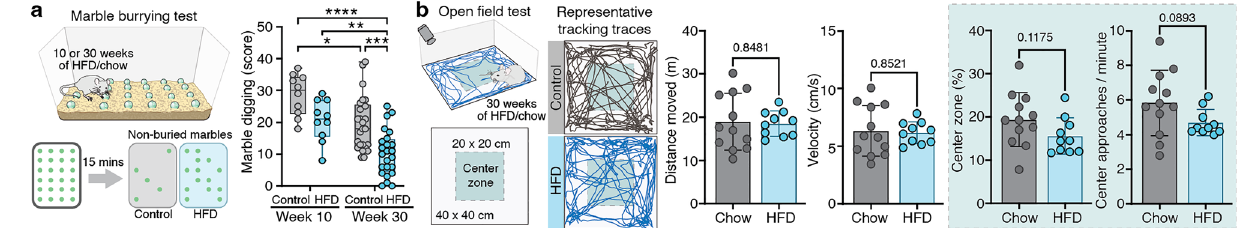
Figure 2. Long-term high-fat diet (HFD) impairs behavior but not mobility of mice. ( a ) Schematic of marble burying test and quantification of marble burying score (2-way ANOVA, n = 10 (10 weeks) and 24–25 (30 weeks)). ( b ) Schematic of open field test followed by quantification of moved distance (meter) (left panel), velocity (cm/s) (second panel), time spent in the center zone (percent) (green shaded left panel) and center approaches per minute (green shaded right panel). n = 10 – 12. Unless otherwise indicated all graphs are analyzed via unpaired t-test. Graphs created with GraphPad software (version 9.0, https:// www. graph pad. com/ scien tific- softw are/ prism/). Schematics created in Adobe Illustrator 2022, https:// www. adobe. com/ produ cts/ illus trator/ free- trial- downl oad. html) by Dan Xue. Representative tracking traces created in MATLAB R2022a and Adobe Illustrator (version 26.3.1, https:// www. adobe. com/ produ cts/ illus trator/ free- trial- downl oad.